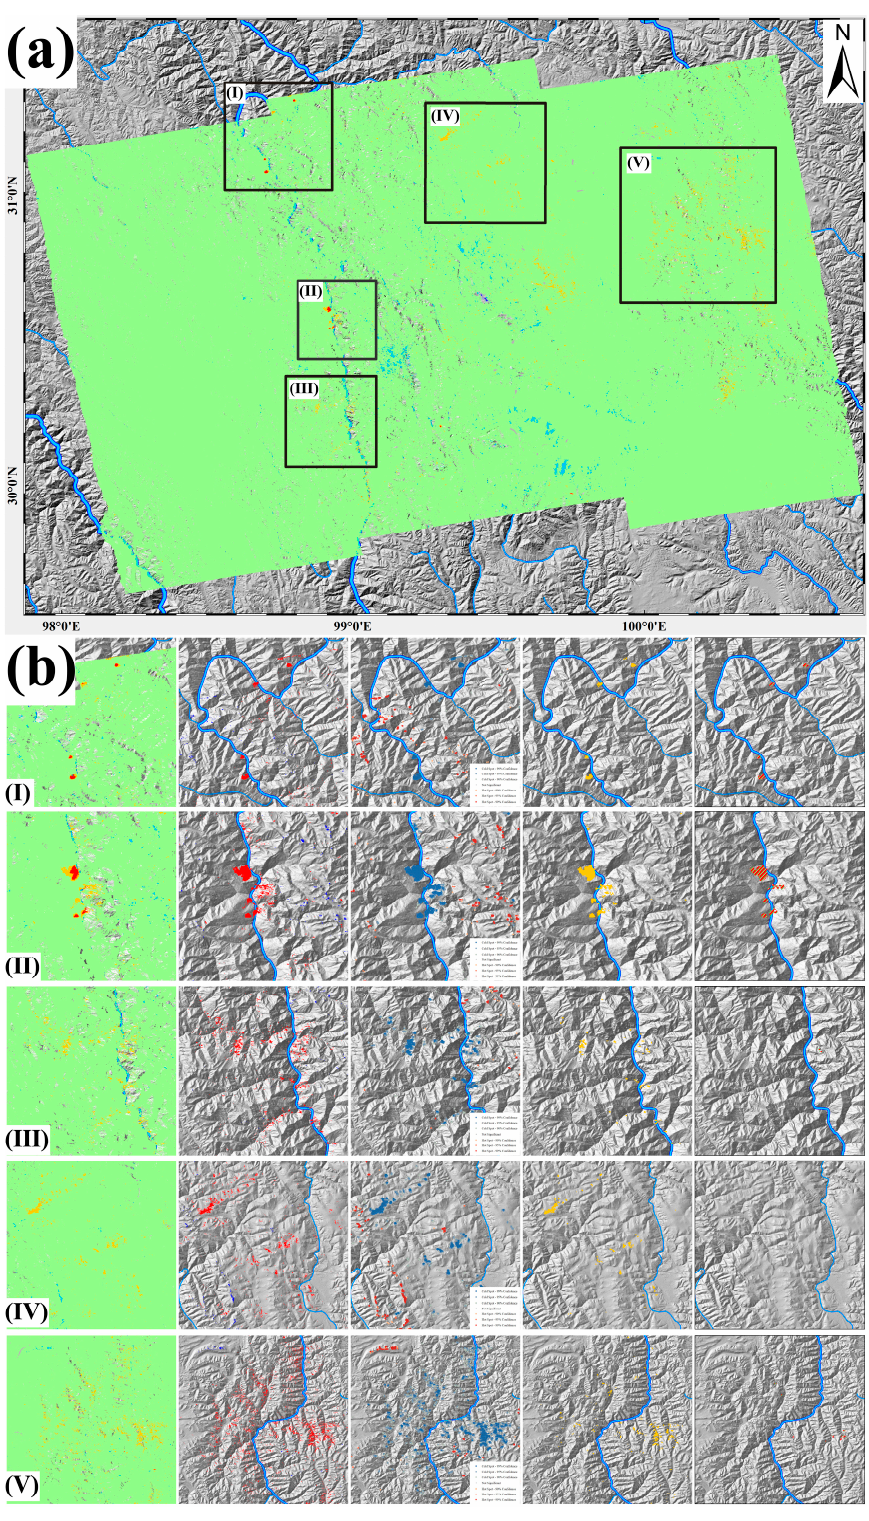
Figure 13. Spatial cluster analysis and landslide identification process. ( a ) Annual velocity map obtained by SBAS. ( b ) Landslide identification process in the five main deformation regions (I–V) of ( a ); each region corresponds to a row (I–V). The five columns of ( b ) are the enlarged deformation maps, the extracted DR, the hotspot analysis results, the polymerized landslide polygons, and the screened landslides,